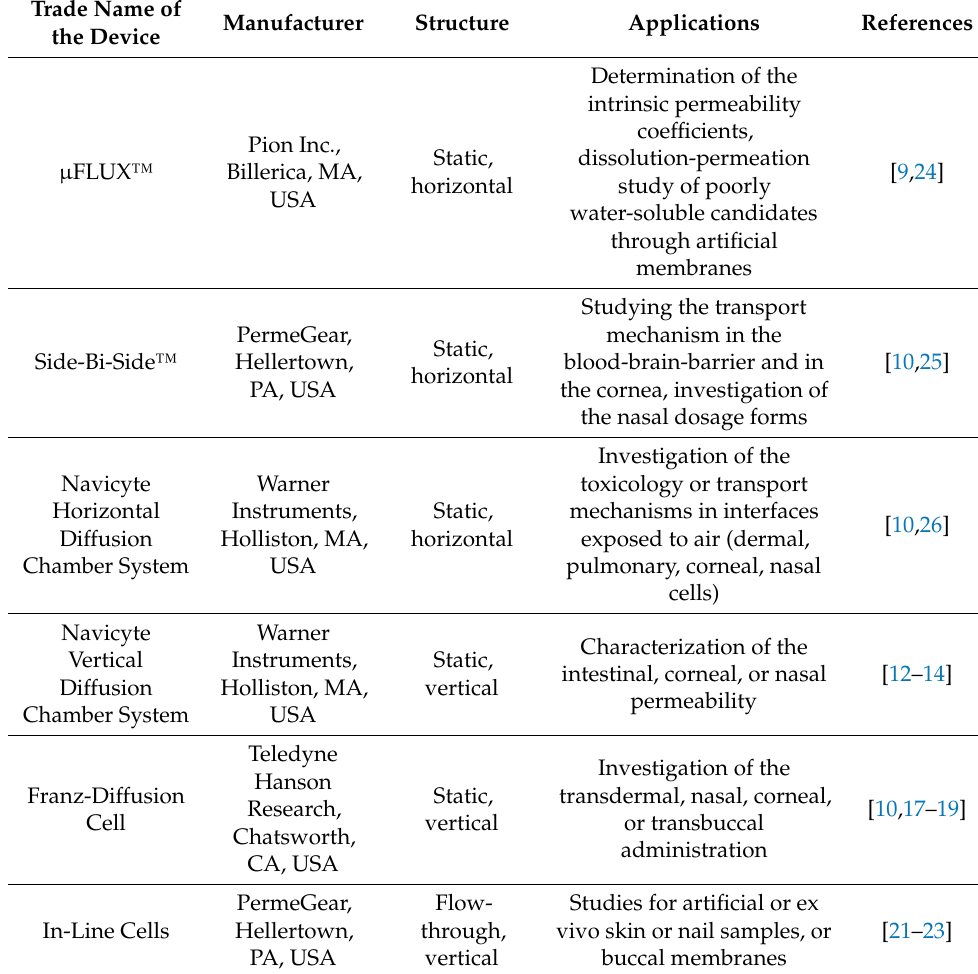
Table 1. Comparison of different diffusion cell